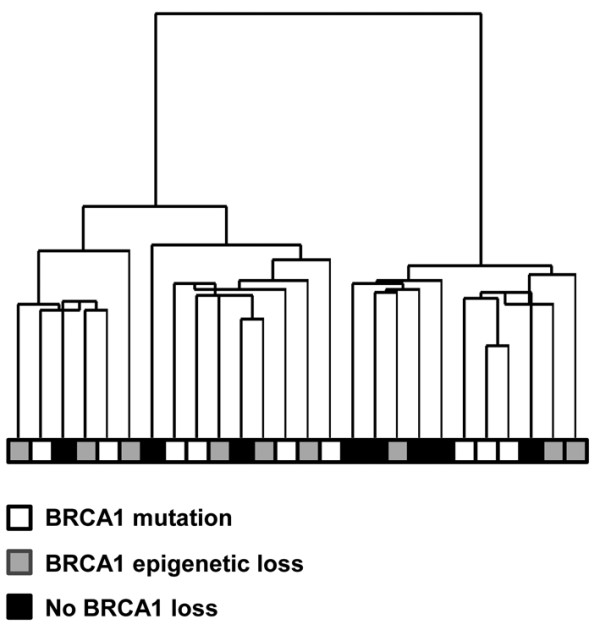
Unsupervised hierarchical clustering of high-grade serous carcinomas of the ovary with different BRCA1 status. Based on the expression profiles with 1603 filtered genes, there was no tendency for tumors to cluster based on BRCA1 status (BRCA1 loss through mutation, BRCA1 epigenetic loss through promoter hypermethylation, and no demonstrable BRCA1 loss). The length of the dendrogram arms is inversely proportional to the relatedness of gene expression between cases.